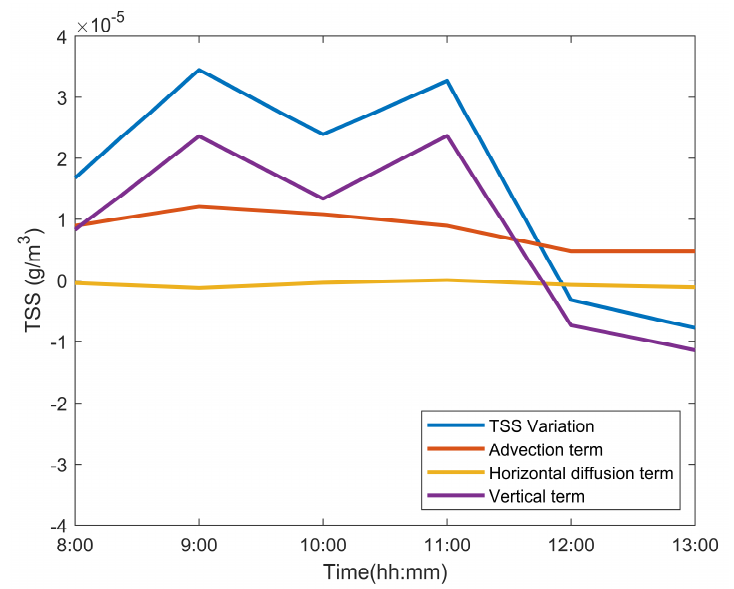
Figure 9. The hourly variation in TSS, advection term, horizontal diffusion term, and vertical term from 08:00 to 13:00 on 3 August 2013.